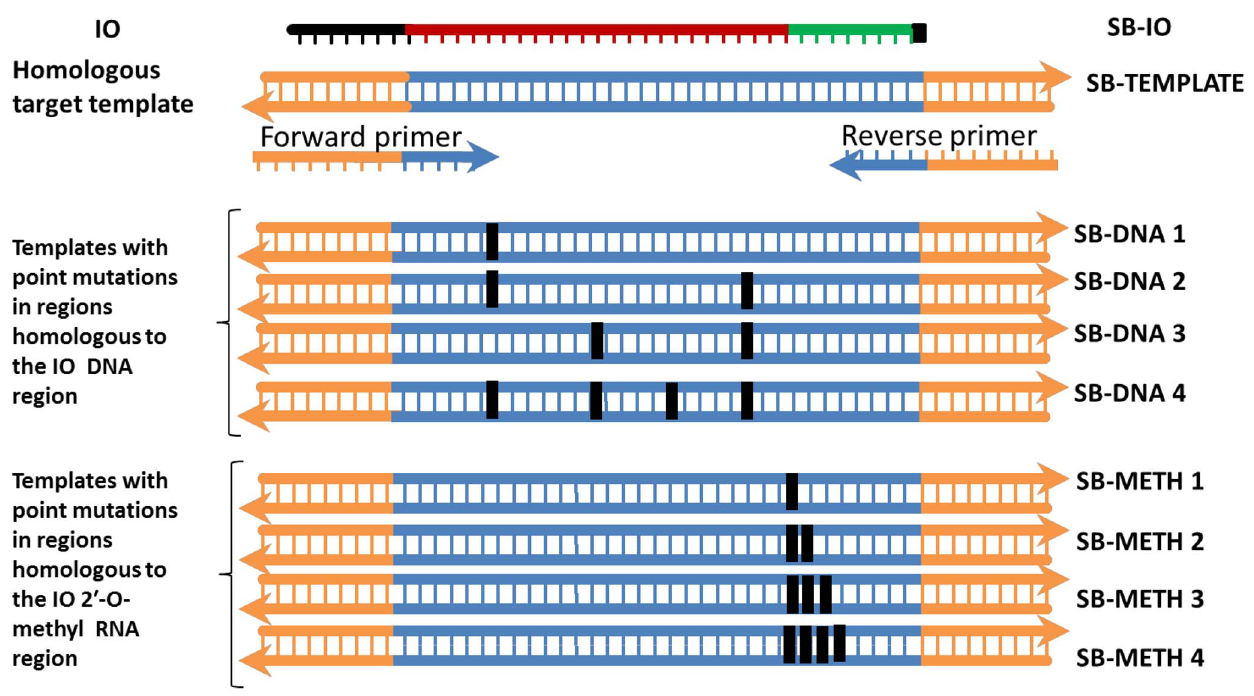
Figure 4. Configuration of templates used for evaluating the sensitivity of SIBA for point mutation(s). Eight additional templates harboring different numbers of point mutation(s) 1–4 were synthesized. The point mutation(s) were either located in regions homologous to the IO DNA or the IO 2 9 -O-methyl RNA region (SB-IO). The black box on the templates indicates the location of the point mutation